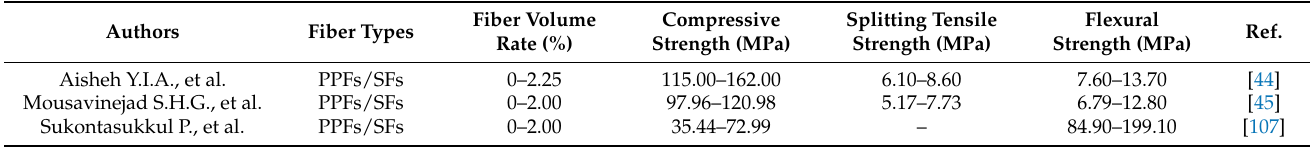
Table 10. The effect of hybrid fiber volume rate on geopolymer